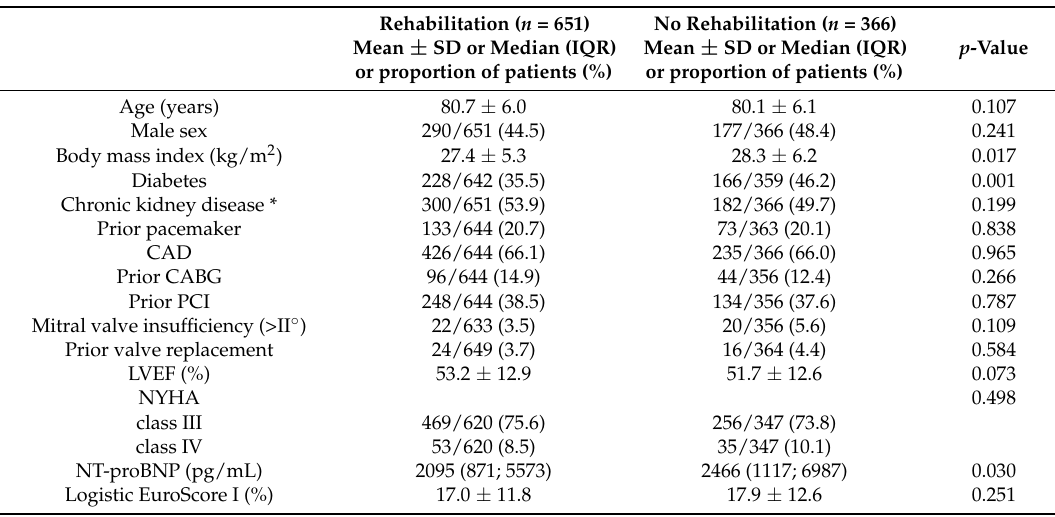
Table 1. Patient characteristics at